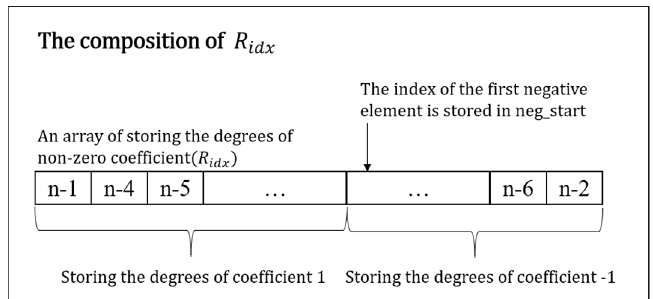
Figure 1. Representing (cid:1844) (cid:3036)(cid:3031)(cid:3051) array in [7].